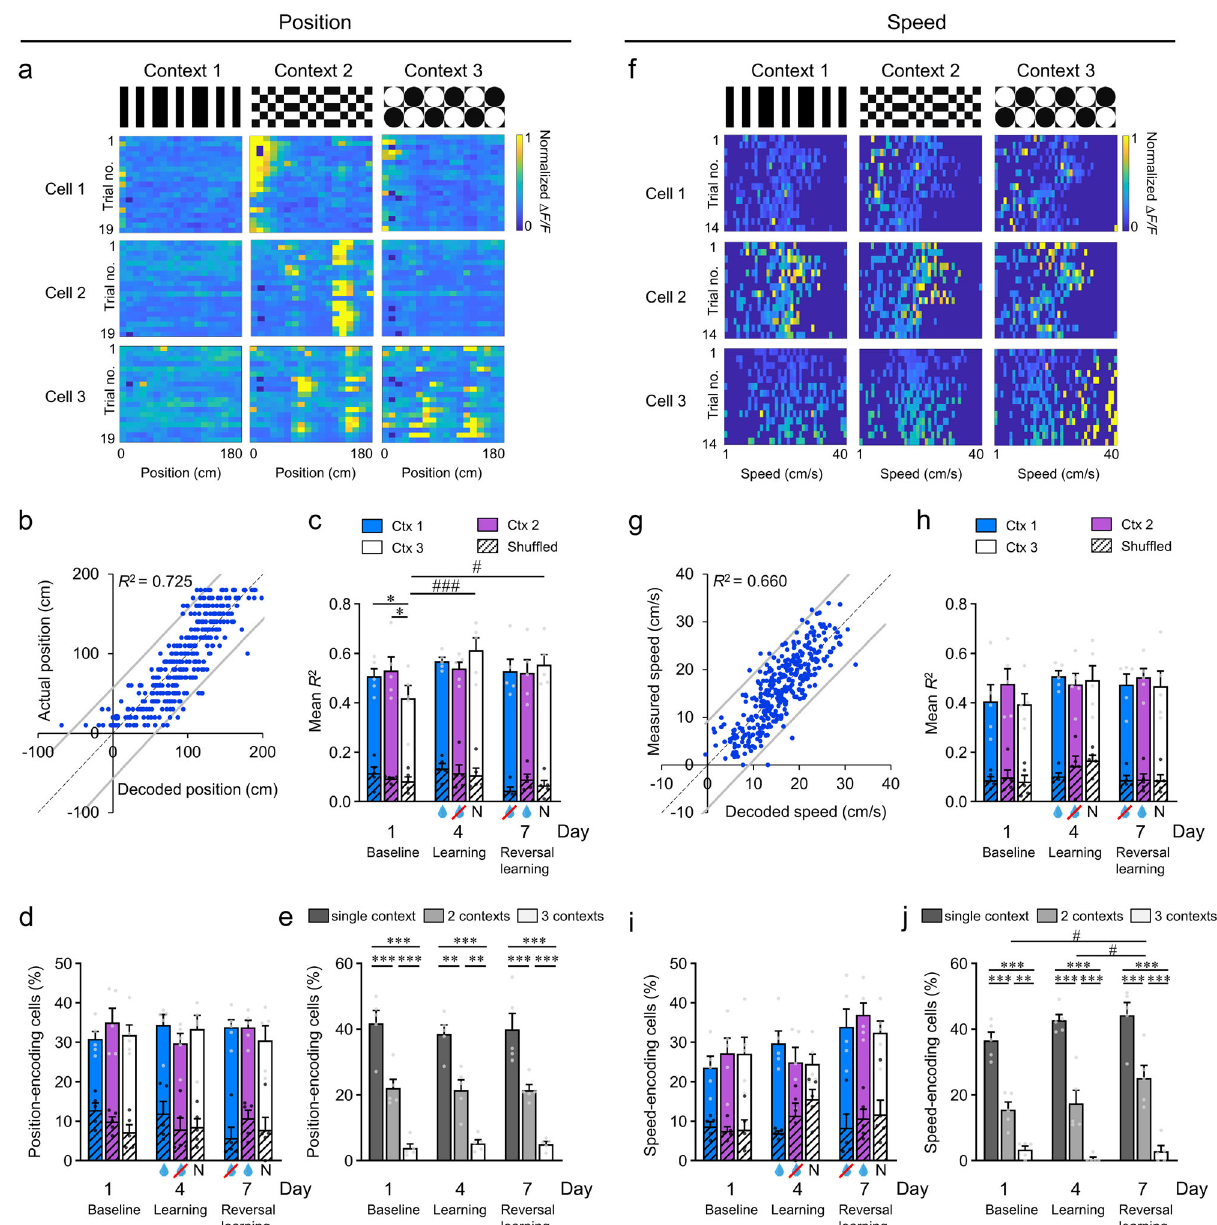
Fig. 4 Neurons in the dysgranular RSC encode position-related and speed-related information. a Normalized response ( Δ F/F ) at positions along the virtual corridor (0 – 180 cm) of three position-encoding neurons across multiple trials. b Example linear regression plot for the actual position and the position decoded from the neuronal activity for one animal and one context; a high R 2 value (0.725) indicates a good fi t of the linear regression model to the observed data. c Mean R 2 of position decoded in each context on baseline (day 1), learning (day 4), and reversal learning (day 7). d Proportion of position-encoding cells across contexts and days. e Context speci fi city of position-encoding cells on each day. f Normalized response ( Δ F/F ) of three speed-encoding neurons in the RSC across multiple trials as a function of running speed. g Example linear regression plot for actual speed versus speed decoded from the neuronal activity for one animal and one context; a high R 2 value (0.66) indicates a good fi t of the linear regression model to the observed data. h Mean R 2 of actual and decoded speeds in each context across days. i Proportion of speed-encoding cells across contexts and days. j Context speci fi city of speed-encoding cells on each day. For all, n = 5 mice. For c – e and h – j , data are presented as mean values + SEM. For c , d , h , and i , results after random shuf fl ing of the raw data are shown in a diagonal-stripe pattern. For c – e and h – j , experimental data points are shown as gray dots and the shuf fl ed data points are shown as black dots. Two-way RM ANOVA and post-hoc Holm – Sidak tests were used. Within-day comparisons: * p < 0.05, ** p < 0.01, ** *p < 0.001; between-day comparisons: # p < 0.05, ### p < 0.001. Exact p- values can be found in Supplementary Dataset 1. Source data are provided as a Source Data fi